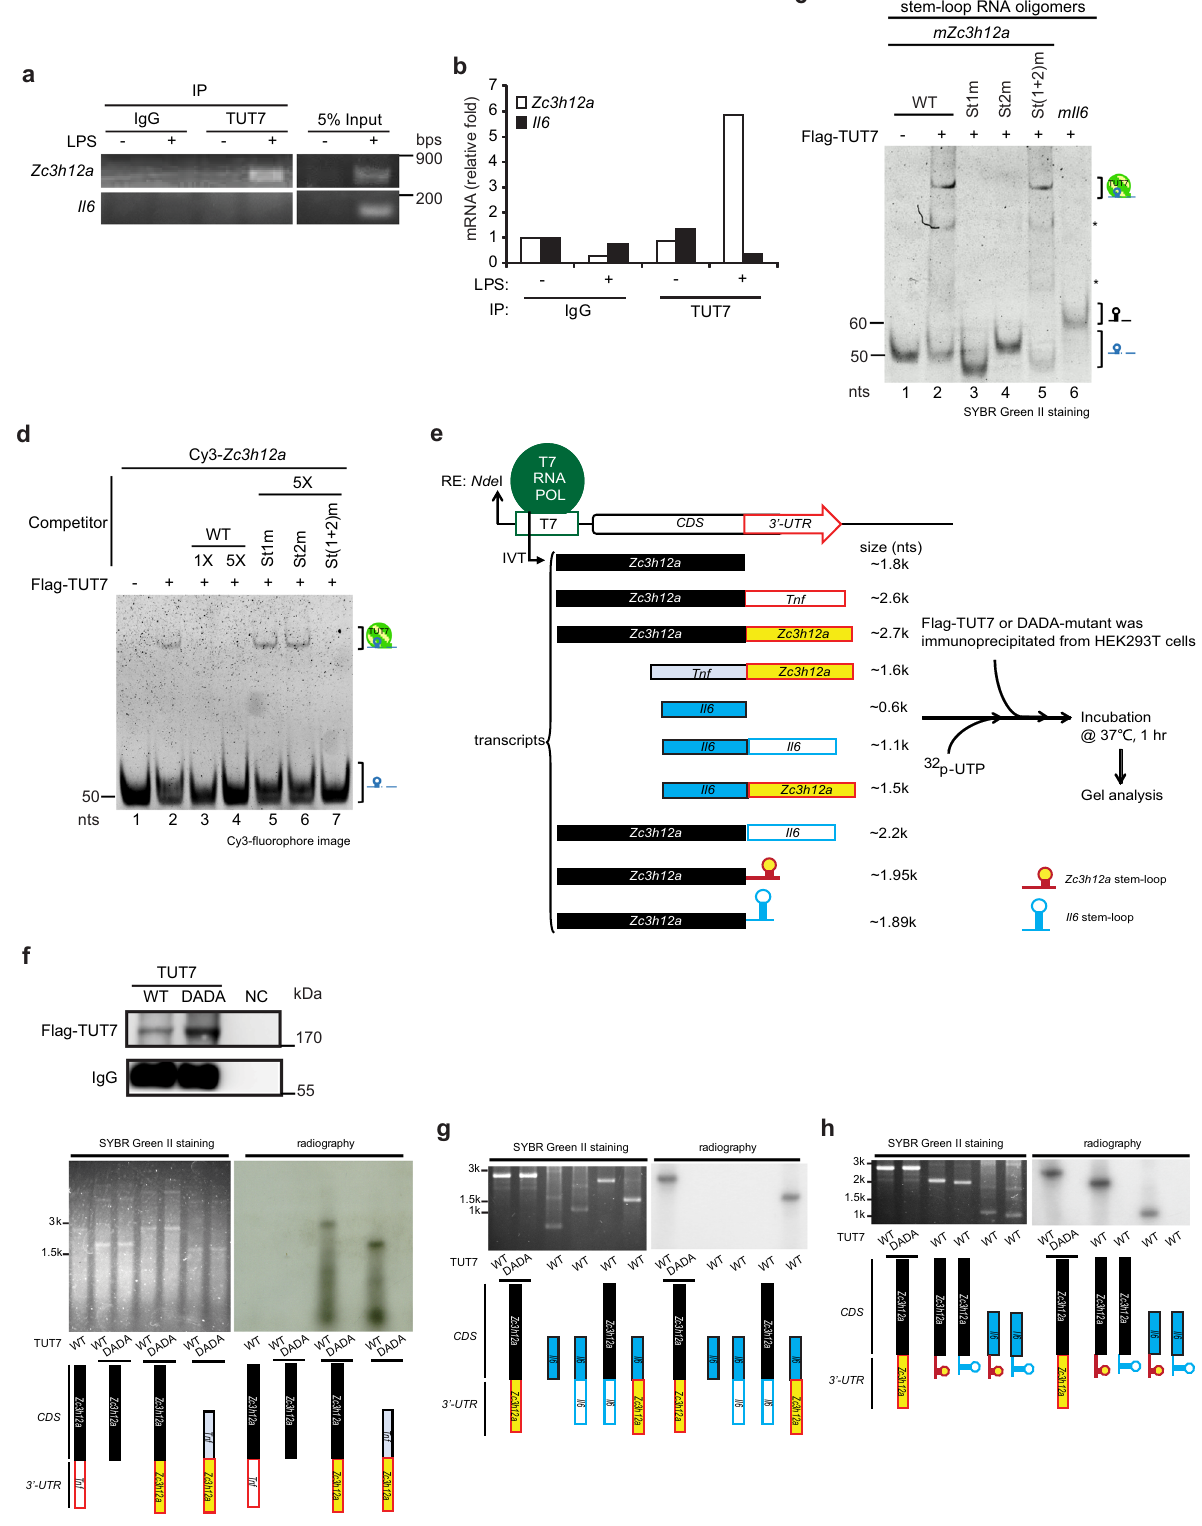
of cytokines and in fl ammatory mediators in the early phase of innate immune responses. Among the members of the TUTase family, TUT7 shares structural and functional homology with TUT4. Both TUT7 and